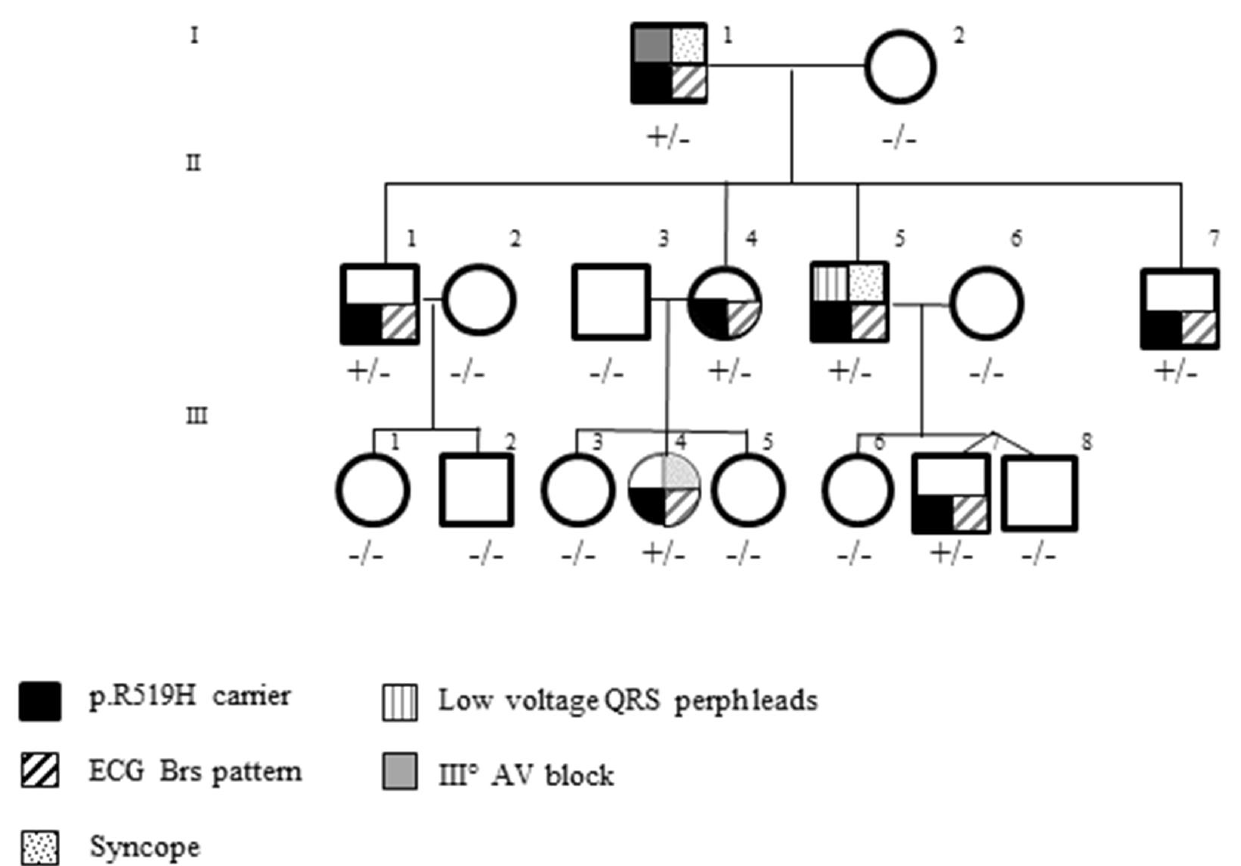
Figure 4. Pedigree of the proband carrying the DLG1 variant. Circles indicate females, squares males. Open symbols represent asymptomatic individuals, filled symbols indicate carriers of the DLG1 variant, the presence of a BrS type 1 ECG and an arrhythmogenic syndrome according to the trauma code. +/ − : heterozygote for p.R519H variant; − / − : non carrier.